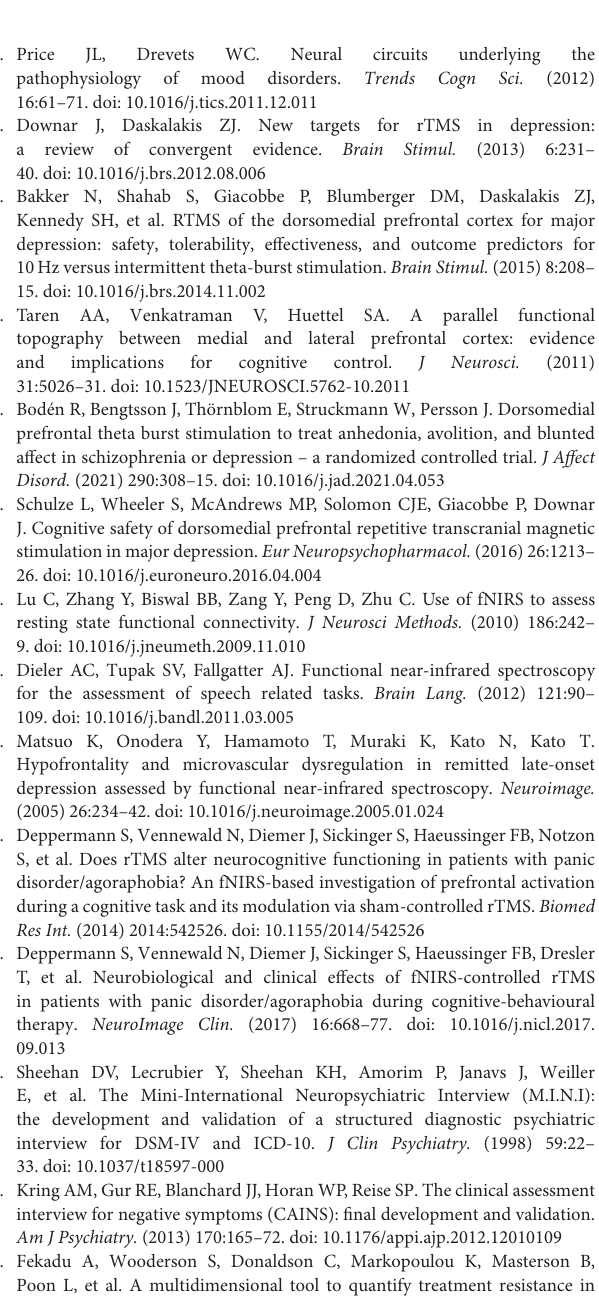
Supplementary Table 3 | Baseline correlation between patients’ negative symptoms as assessed by the Clinical Assessment Interview for Negative Symptoms (CAINS) and prefrontal oxy-Hb during cognitive performance at baseline. RAVLT, Rey Auditory Verbal Learning Test. Significant correlations are marked with an asterisk. Supplementary Table 4 | Baseline correlation between patients’ cognitive performance and concurrent prefrontal oxy-Hb at baseline. RAVLT, Rey Auditory Verbal Learning Test. Supplementary Table 5 | Correlations between controls’ cognitive performance and concurrent prefrontal oxy-Hb. RAVLT, Rey Auditory Verbal Learning